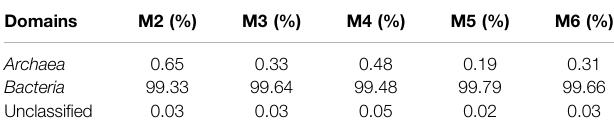
TABLE 2 | Domains distribution in vermiculation deposits from Morgana